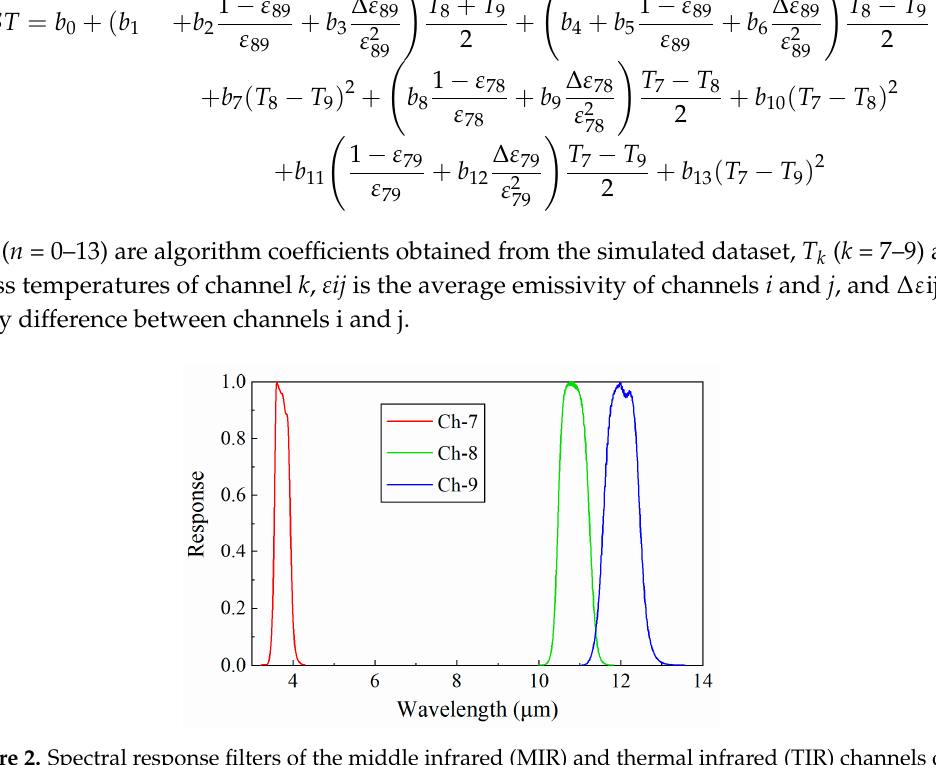
Figure 2. Spectral response filters of the middle infrared (MIR) and thermal infrared (TIR) channels of Sentinel-3A Sea and Land Surface Temperature Radiometer (SLSTR).